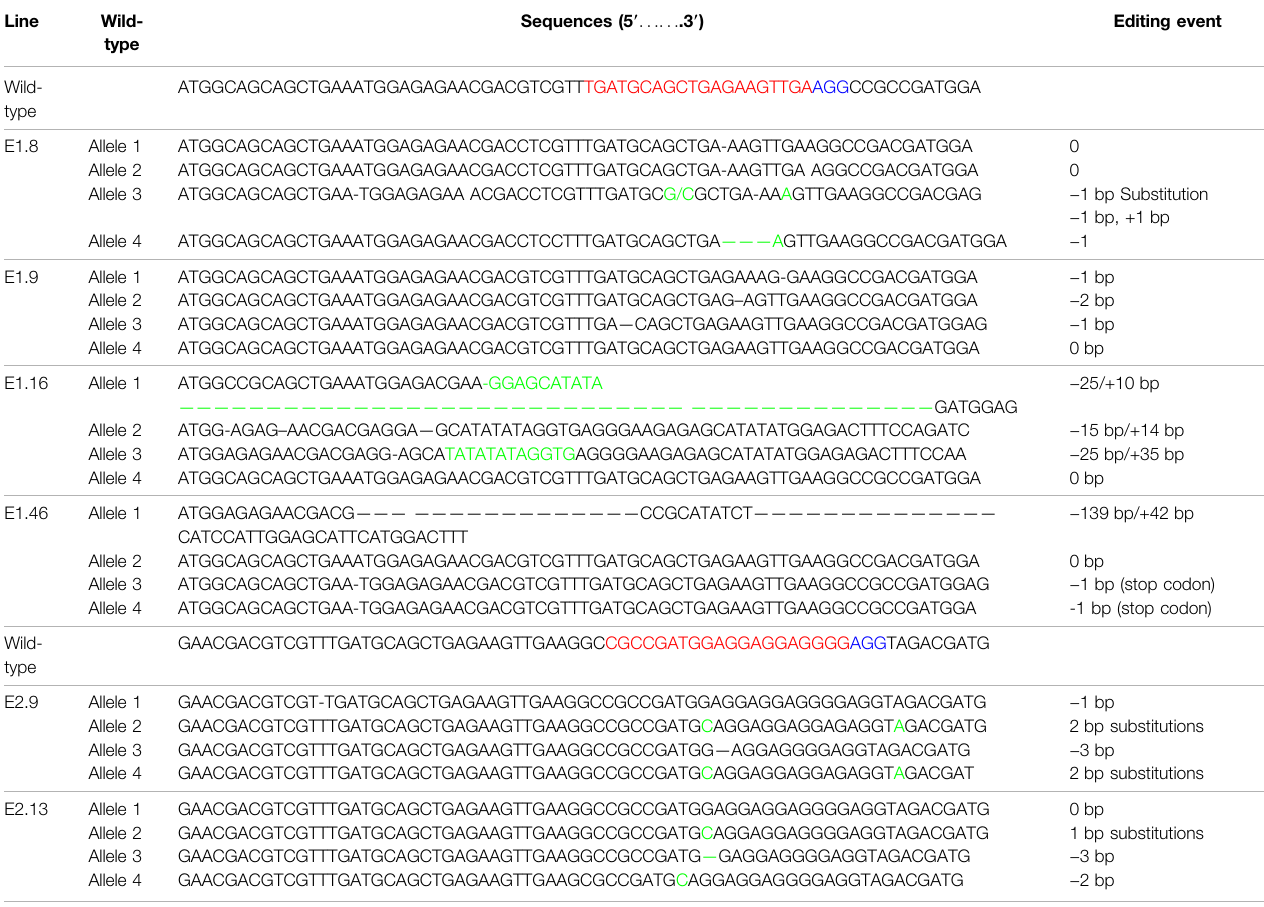
TABLE 2 | Editing events con fi rmation at allelic base through Sanger